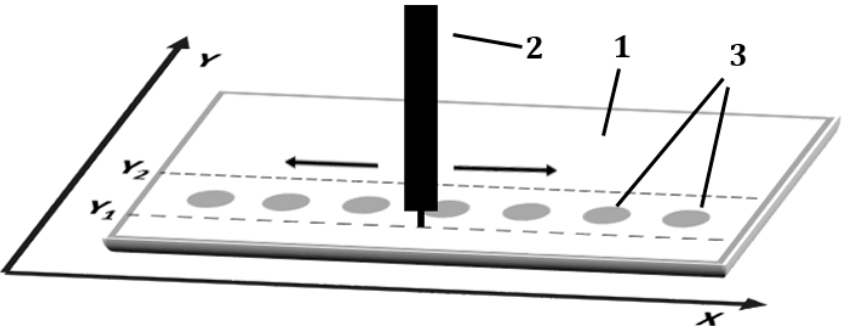
Figure 8. Scheme of the paths represented by the dashed lines for delivering the mobile phase solution to the adsorbent layer with moving pipette driven by 3D machine. 1—chromatography plate; 2—moving pipette; 3—sample spots applied on the chromatographic plate.